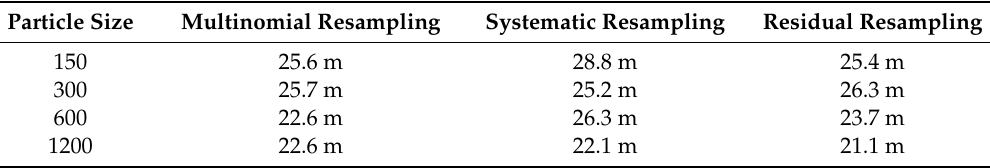
Table 3. Source depth estimation results in di ff erent resampling algorithms and particle